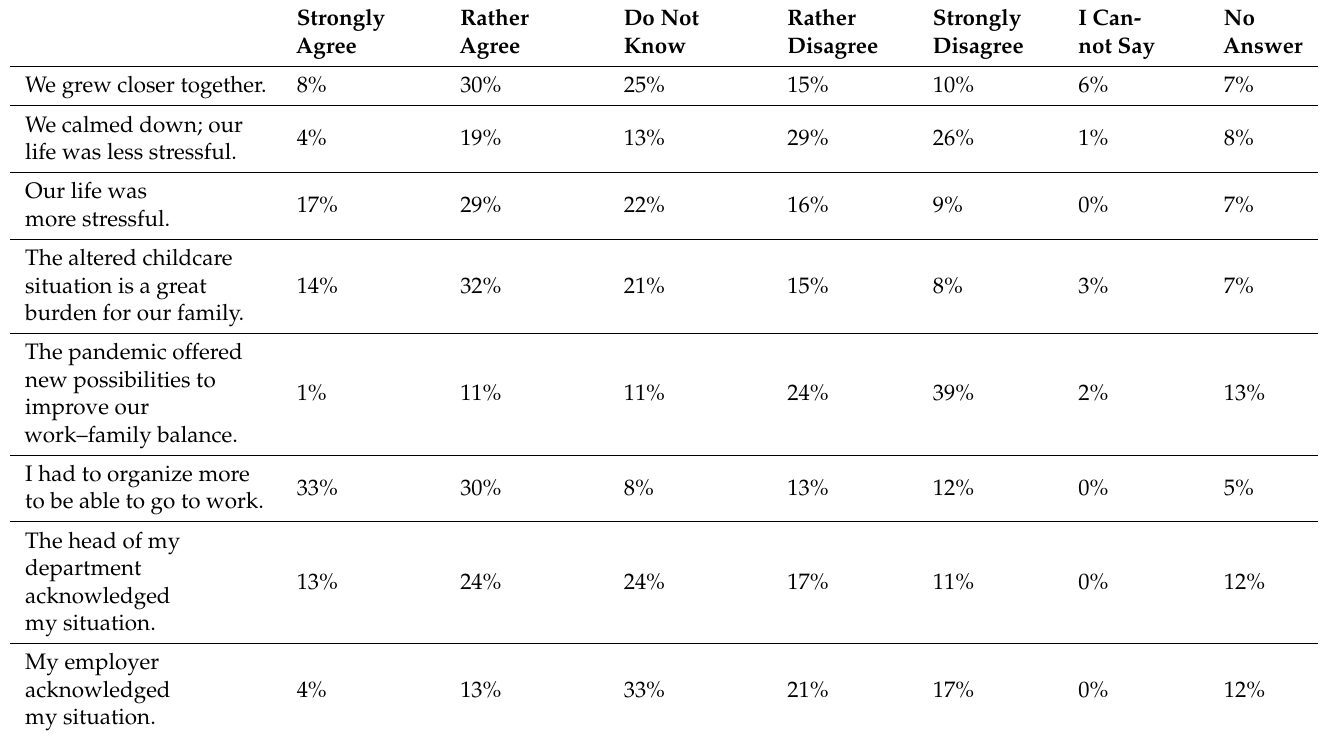
Table 3. Impact of the COVID-19 lockdown on the work–family balance of respondents with under- age